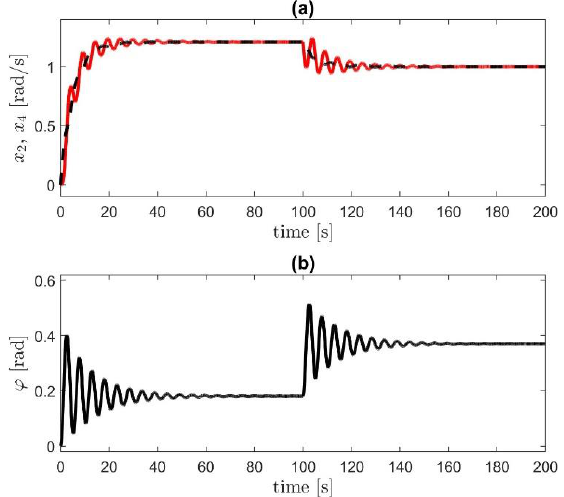
Figure 5. Step response of the motor speed and the load speed, 𝑇 = 1000 [𝑁] : ( a ) load speed 𝑥 2 (solid red line) and motor speed 𝑥 4 (dashed black), ( b ) torsion angle 𝜑 = 𝑥 3 − 𝑥 1 .